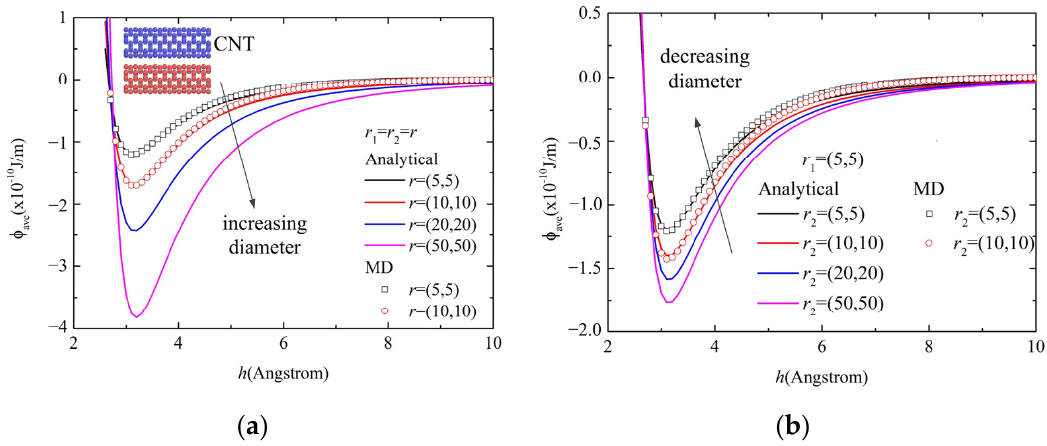
Figure 3. Size effect of cohesive energy of parallel CNTs with ( a ) the same diameter and ( b ) different diameters.